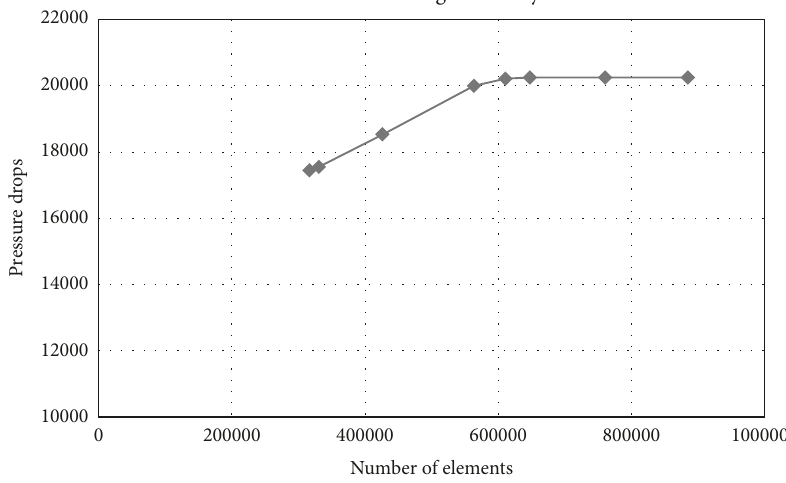
Figure 1: Grid convergence study of Rhizophora mangrove species.